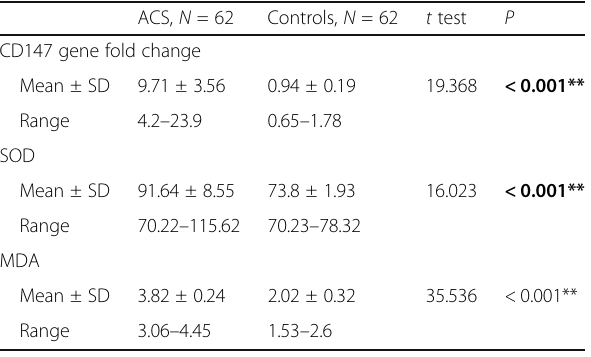
Table 1 A statistical comparison of CD147 gene expression, SOD activity, and MDA level among studied groups